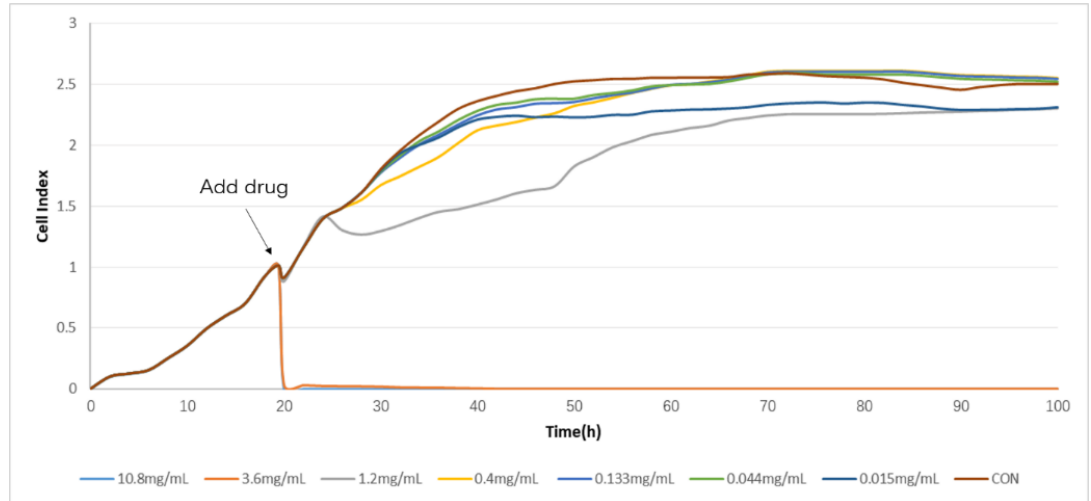
Figure 4. The time/dose-dependent cell response profiles (TCRPs) of the different concentration samples of CDDPs acting on A549 cells plotted against time with the mean of three experiments. The concentrations are: 10.8 mg/mL (light blue line), 3.60 mg/mL (medium brown line), 1.20mg/mL (gray line), 0.400 mg/mL (yellow line), 0.133 mg/mL (medium blue line), 0.044 mg/mL (green line), 0.015 (dark blue line), and control (dark brown line).